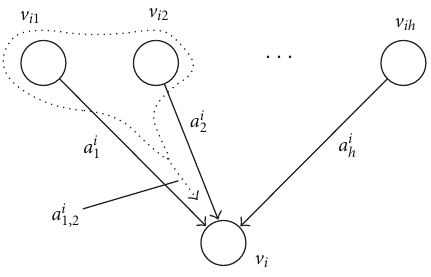
Figure 2: Dynamics model for a